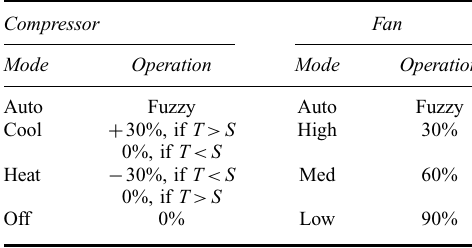
TABLE I System Operation